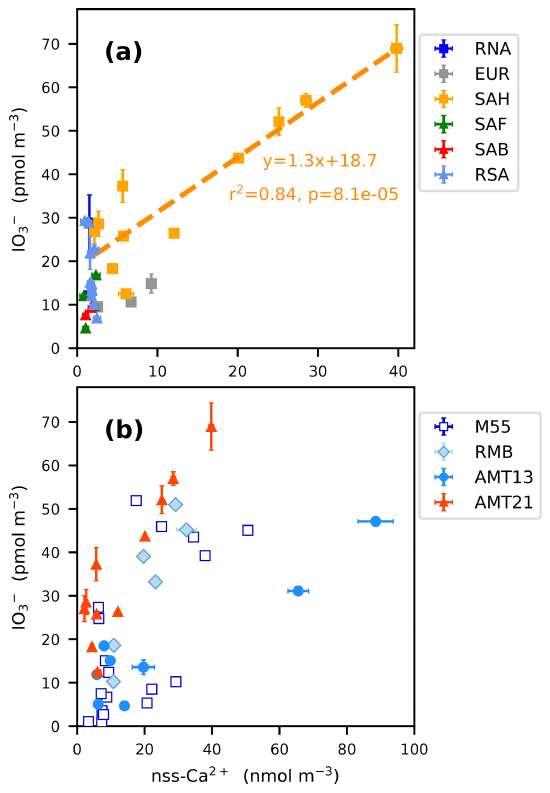
Figure 5. Total (sum of fine and coarse) aerosol IO − as a function of nss-Ca 2 + concentrations for (a) all of the air mass types encountered during AMT21 and (b) for SAH-type samples during the M55, RHaMBLe (RMB), AMT13 and AMT21 cruises. Air mass type codes are described in the text.